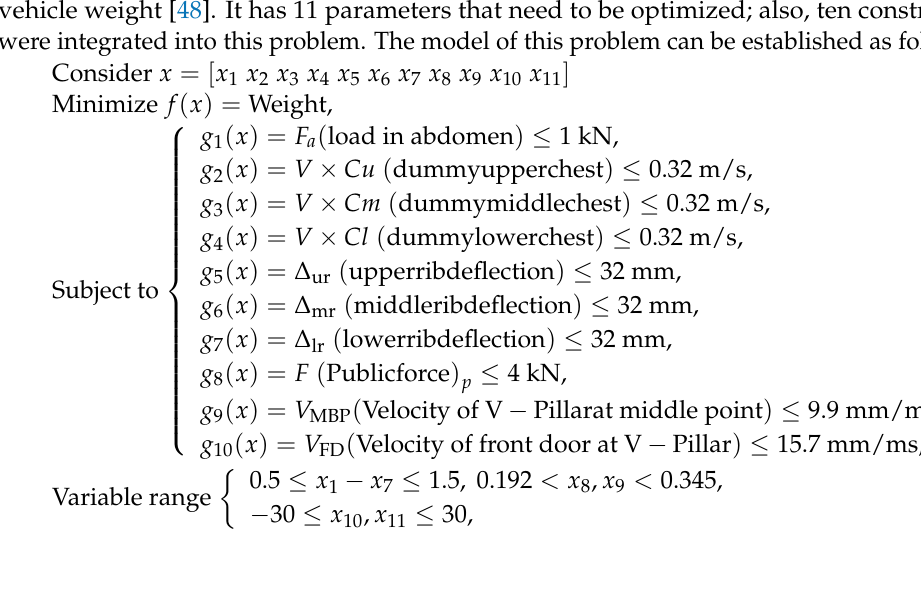
Table 4. Statistical results of Wilcoxon rank-sum test obtained by each algorithm. Function HAGSA vs.